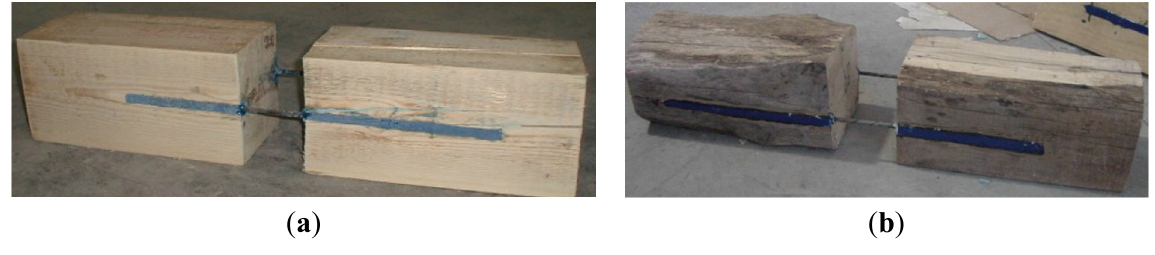
Figure 5. ( a ) Fir wood specimen; ( b ) chestnut wood